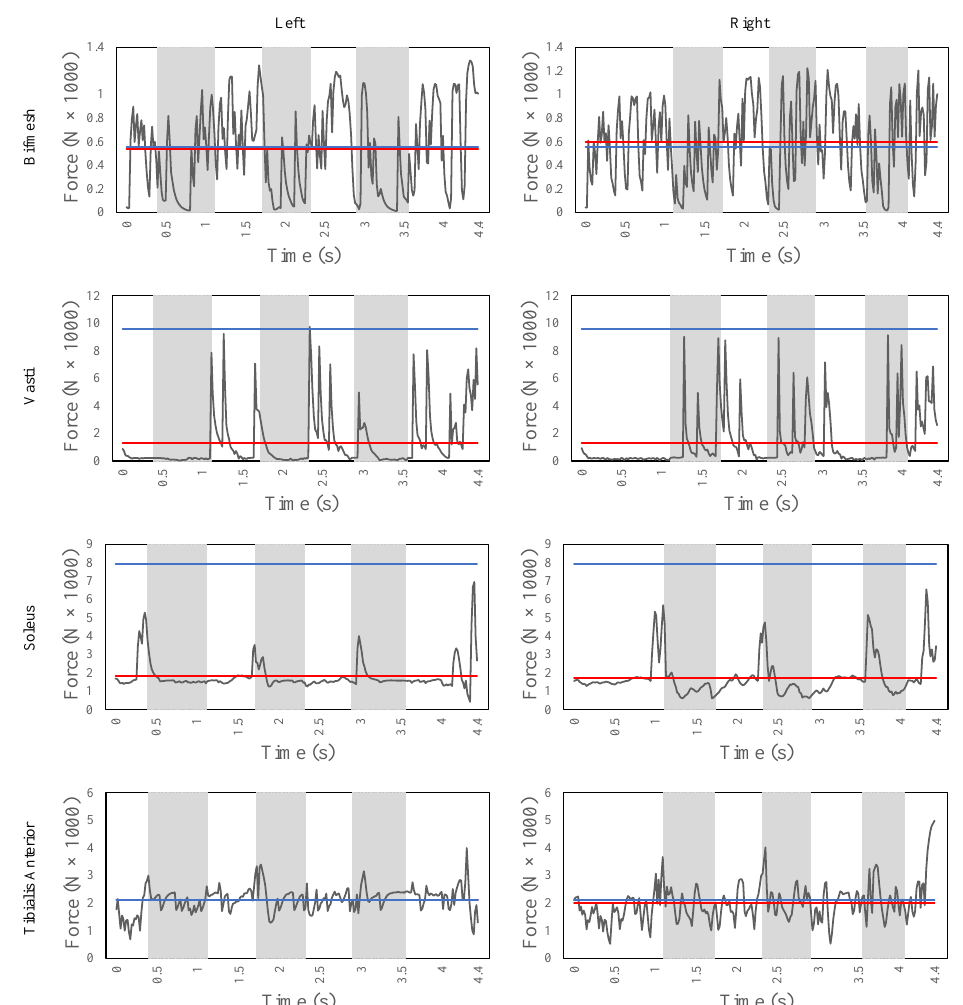
Figure 11. The muscle fiber forces of the bicep femoris, vasti, soleus, and tibialis anterior (from top to bottom) of the human model during ramp ascent for the entire simulation time. The figures on the left side refer to the left leg, while the ones on the right side refer to the right leg. The horizontal red line indicates the mean fiber force, while the horizontal blue line indicates the maximum isometric forces. Figure 12 shows the ground reaction forces in the Y direction, computed at the zero moment point of each foot during ramp ascent (i.e., each foot is in contact with the ground four times and is lifted three times). The Y-component often shows peaks. It maxes out at a force of − 2668 N on the left leg and − 2469 N on the right leg. It has an average (not including zero values) of − 527 N on the left leg and of − 616 N of the right leg.